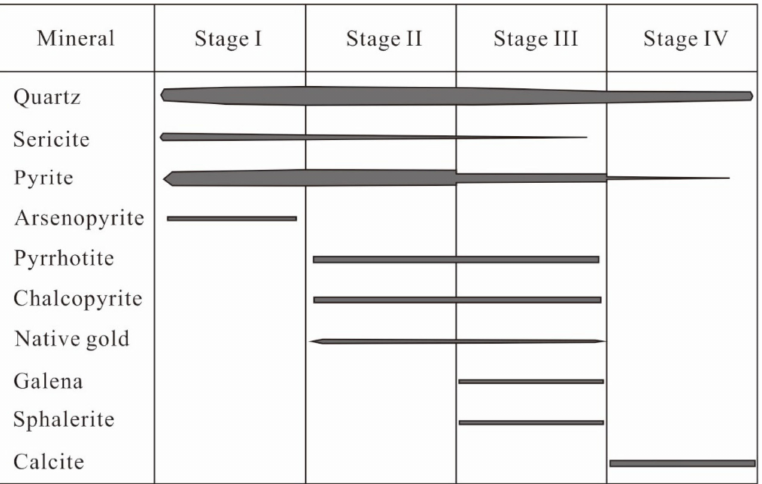
Figure 4. Paragenetic sequence of hydrothermal minerals in the Sanakham gold deposit, with line thickness indicating the relative abundance of